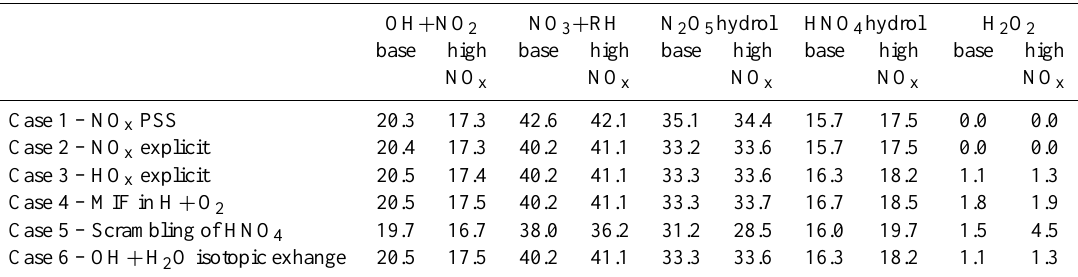
Table 8. Comparison of diurnally-integrated source isotopic signature (DIIS, in ‰ units) for the four nitrate and H 2 O 2 production channels considered, respectively under mid-latitude (45 ◦ N, 293K) and under starting NO x levels of 20pmolmol − 1 (base) and 2nmolmol − 1 (high NO x ) in springtime (1 April).